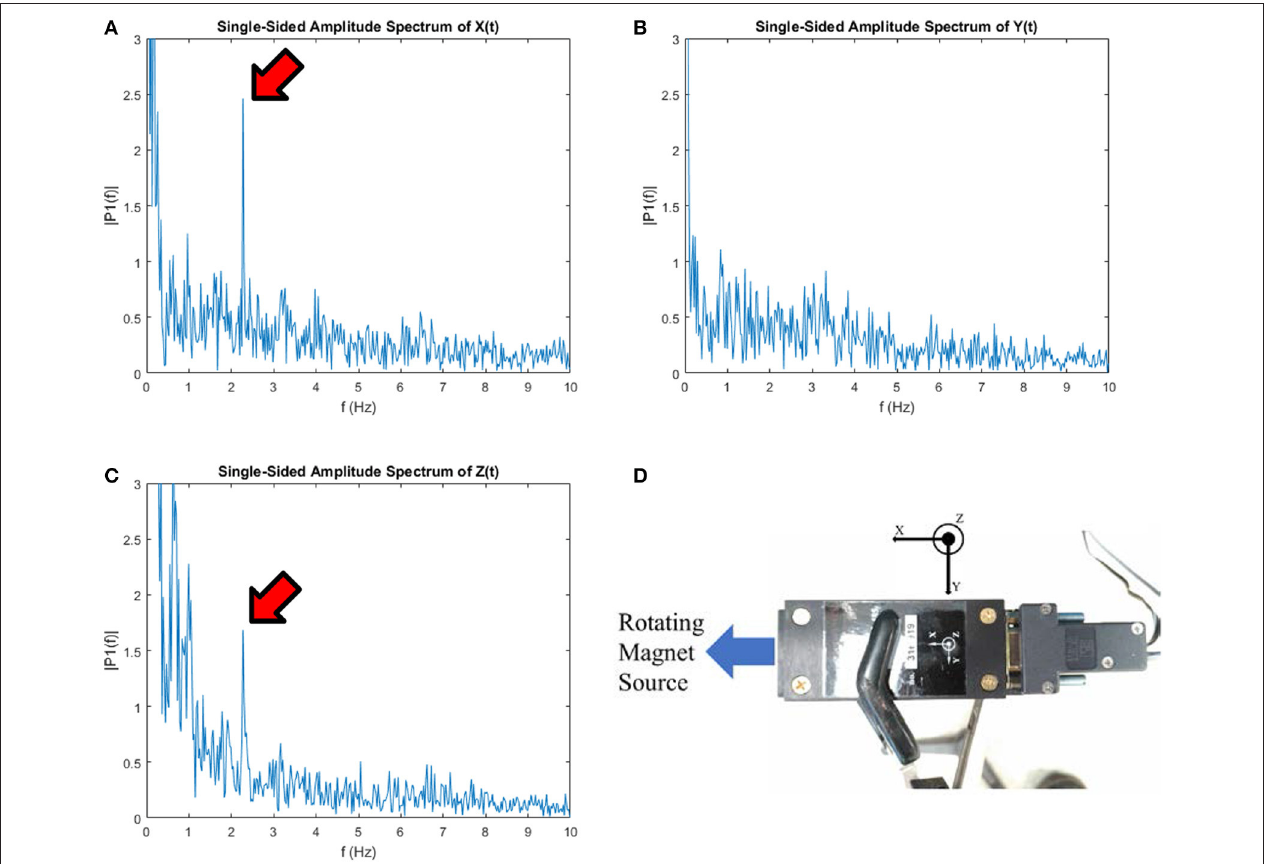
FIGURE 9 | (A–C) Three views of rotating magnet flow meter SolidWorks Model.